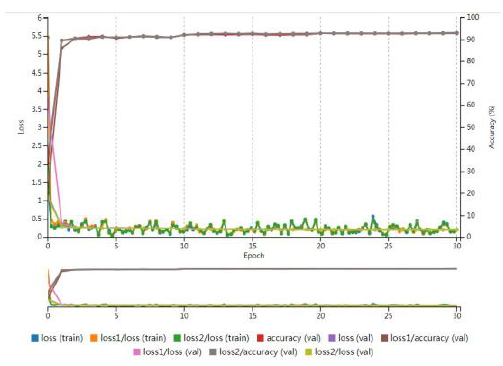
Figure 3. Model training accuracy with 1m resolution samples